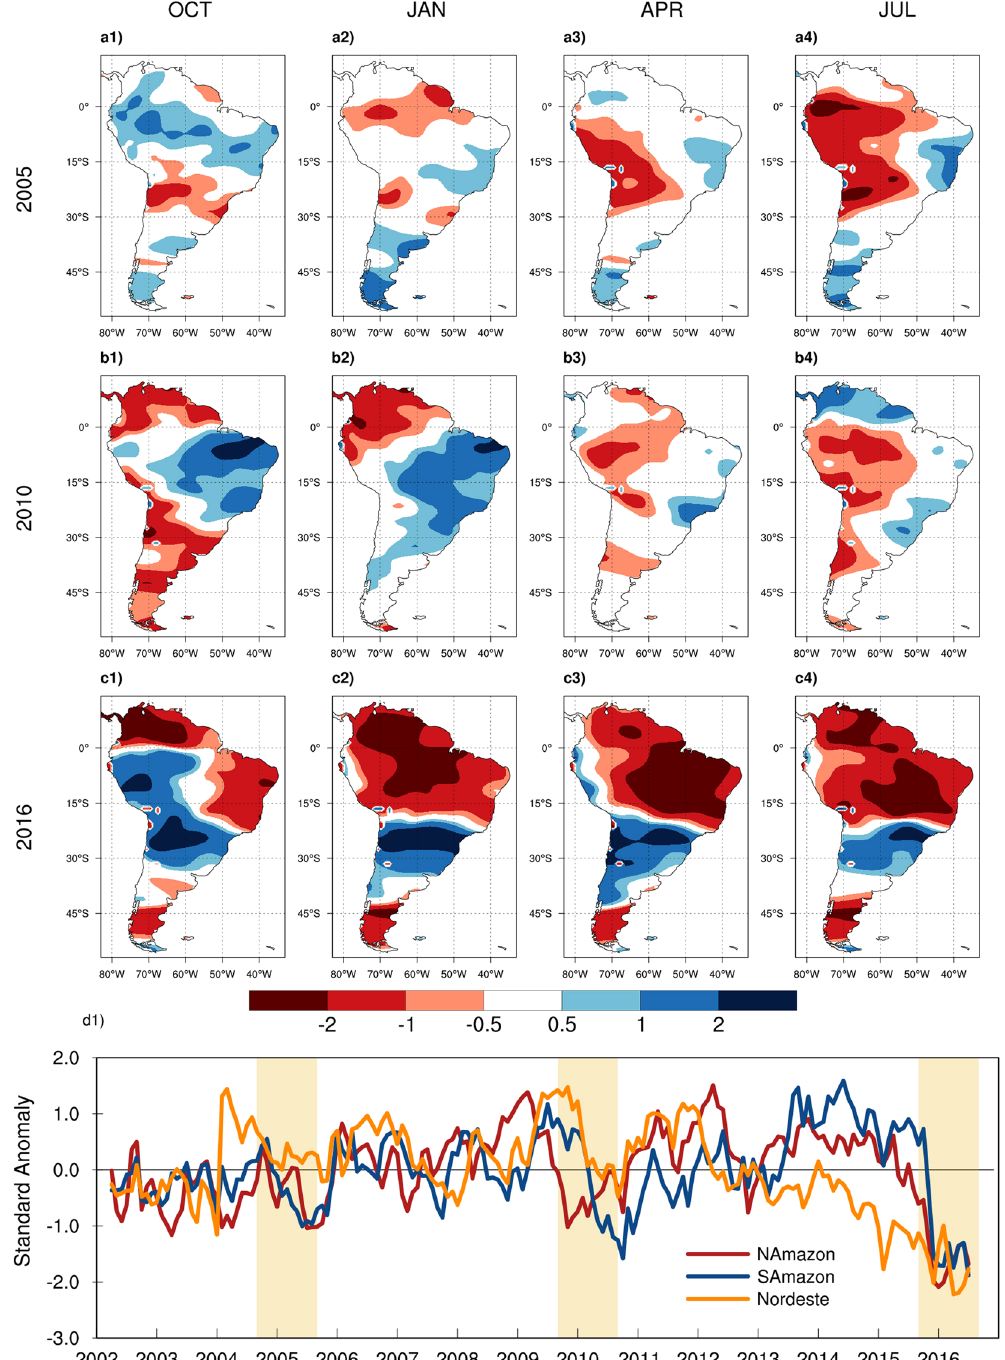
Figure 3. Spatial maps and time series of TWS standardized anomalies calculated using GRACE data from 2002 to 2017. The contour plots present the seasonal anomalies for the three extreme droughts of 2005 ( a1,a2,a3,a4 ), 2010 ( b1,b2,b3,b4 ), and 2016 ( c1,c2,c3,c4 ). The monthly time series ( d1 ) were constructed by averaging anomalies over the North Amazon, South Amazon, and Nordeste regions and the highlight strips denote the extreme droughts represented in the spatial maps. Seasonal cycles for each year start from September of the previous year (e.g. SON 2004 for 2005 seasonal cycle). Figures created with: The NCAR Command Language (Version 6.3.0) [Software]. (2016). Boulder, Colorado: UCAR/NCAR/CISL/TDD.